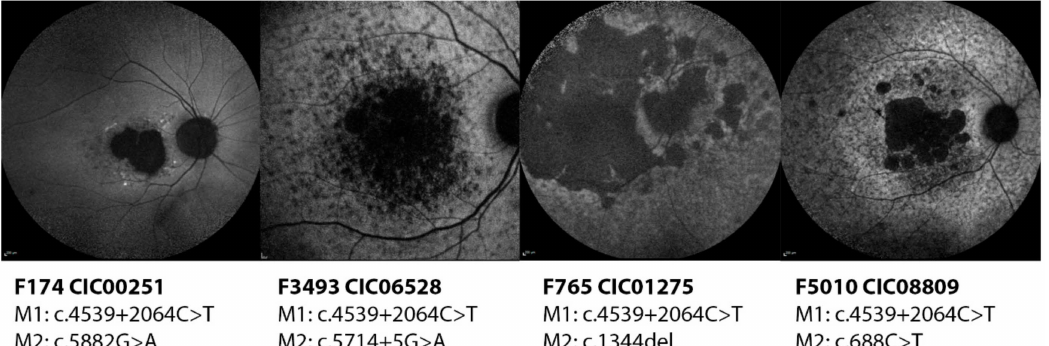
Figure 2. Short wavelength autofluorescence images of the right eyes of four patients carrying the deep-intronic variant c.4539 + 2064C > T. All phenotypes look quite advanced with foveal involvement and di ff use flecks and atrophy at the posterior pole except CIC00251, who carries the mild variant c.5882G > A.